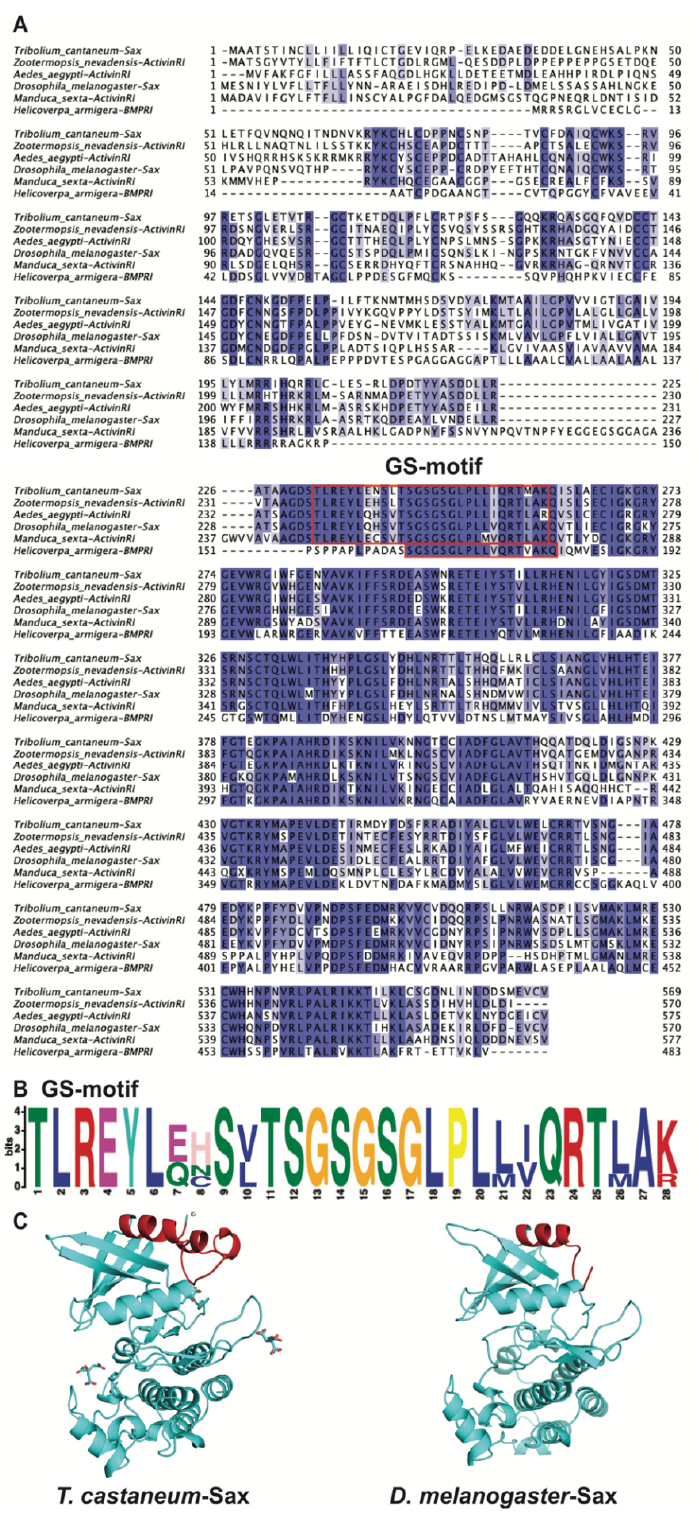
Figure 1. Sequence alignment and protein modeling of TGF- β RIs. ( A ) Multiple-sequence alignment of TGF- β RI amino acid sequences. Conserved amino acid sequences are indicated by a dark blue background. Identical and highly similar amino acid sequences are indicated by a light blue back- ground. Sequences surrounded by red frames represent the GS motif. ( B ) The MEME motif search result of GS motif in the sequences in Figure 1A. ( C ) Molecular model of the three-dimensional structure of Sax kinase domain in T. castaneum and D. melanogaster . The GS motif is colored